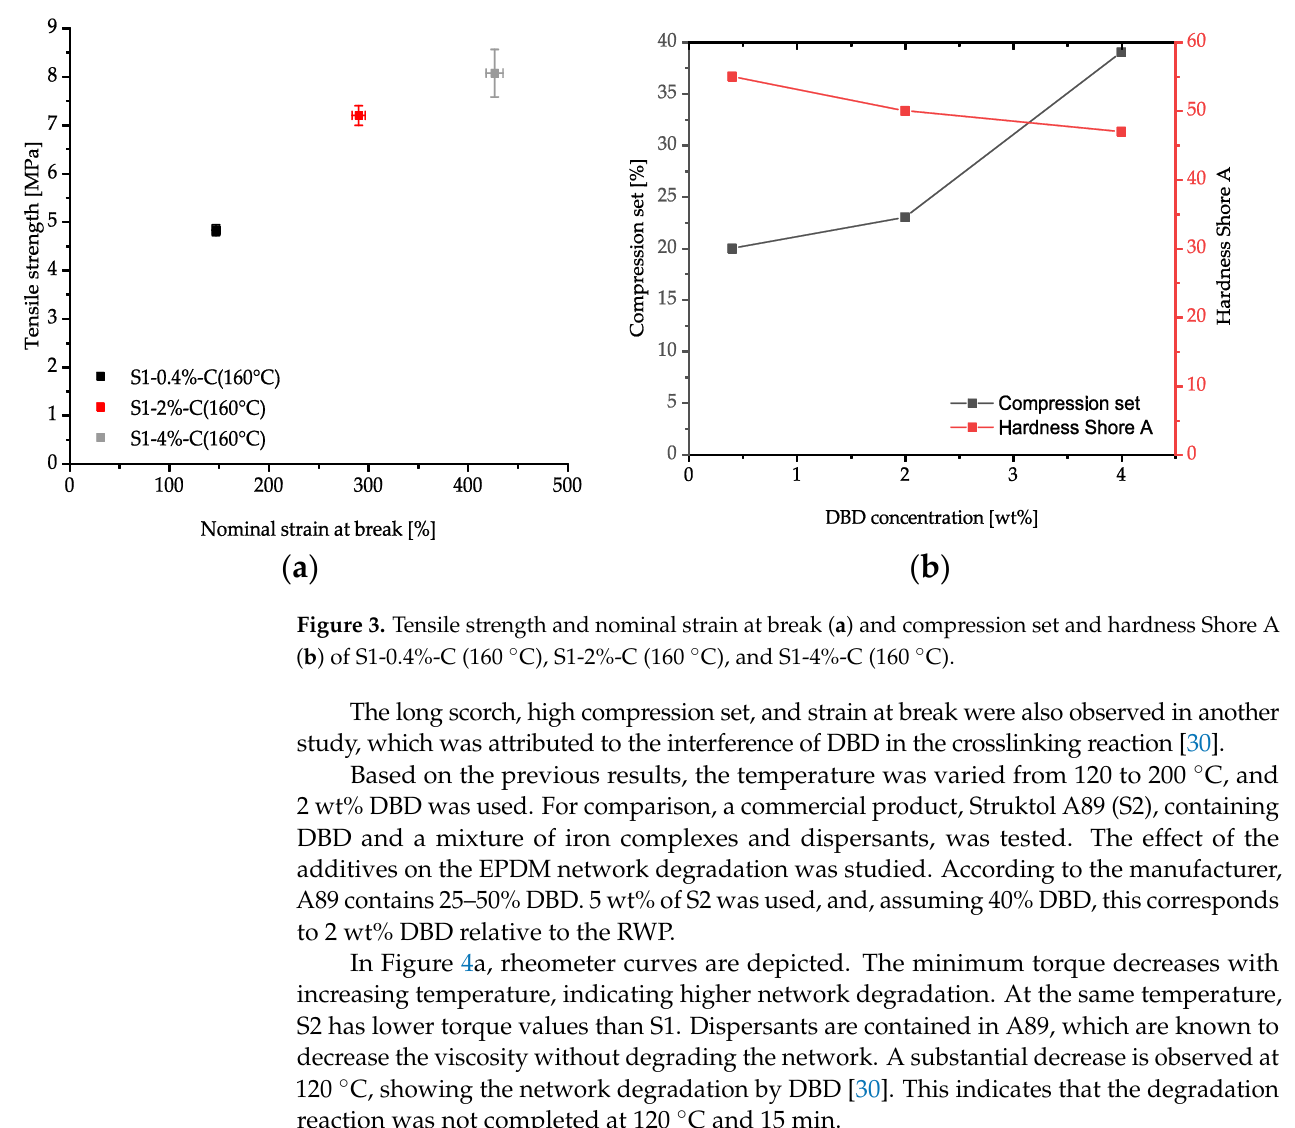
( b ) Figure 4. Rheometer curves recorded at 180 °C ( a ), tensile strength (black), and nominal strain at break (red) ( b ) for S1-2%-C ( ∎ ) and S2-5%- C (∆) as a function of devulcanization temperature. A higher devulcanization temperature leads to stronger network degradation (mini- mum torque in the rheometer curves) and better tensile strength (Figure 4b). The strain at break decreases slightly. For a good quality recyclate, low temperatures are preferable [26]. The tensile strength and nominal strain at break are higher for all temperatures in S1